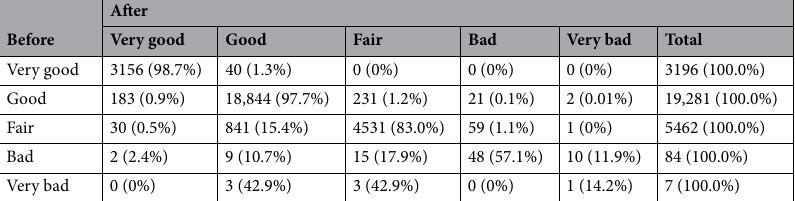
Table 1. The frequency table of mood states before and after 28,030 contacts reported by the ego of the 963 triplets.